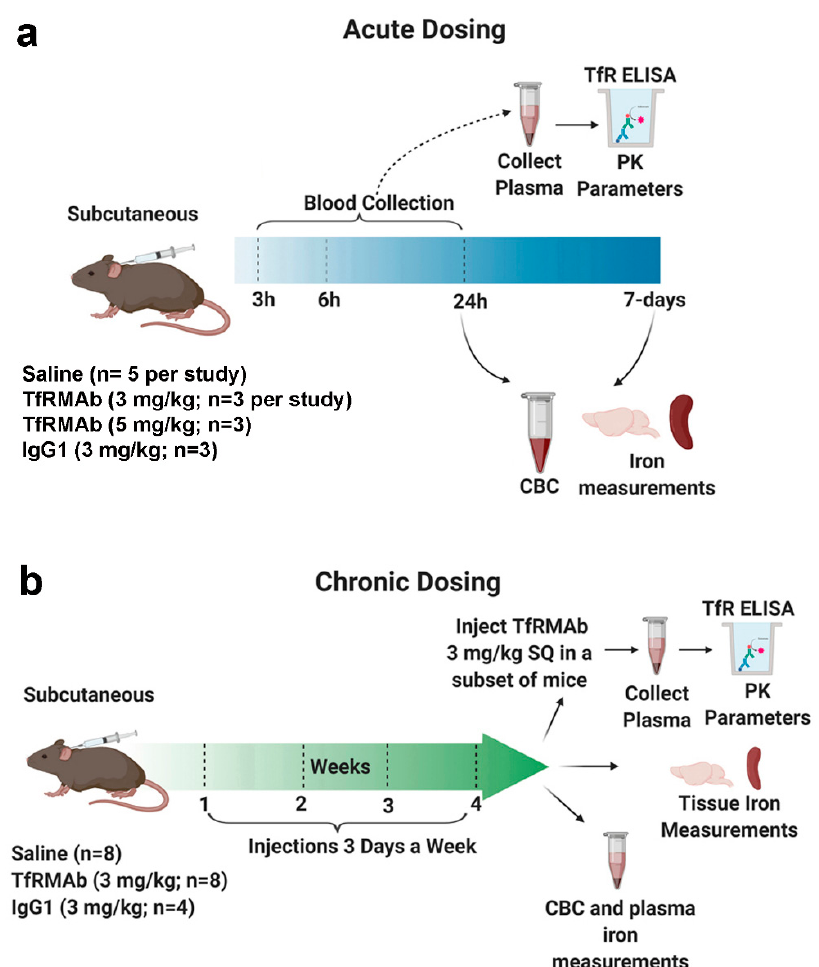
Figure 1. Schematic diagram summarizing the experimental study design for acute ( a ) and chronic ( b ) dosing. For acute dosing study, 22 mice were randomly assigned to receive 3 mg / kg ( n = 3) or 5 mg / kg ( n = 3) SQ dose of TfRMAb, 3 mg / kg SQ IgG1 control ( n = 3), or saline ( n = 5). Plasma was collected at 3-, 6-, and 24-h after injection to determine TfRMAb plasma concentrations in mice dosed with the 3 and 5 mg / kg TfRMAb. Terminal whole blood was collected for a complete blood count (CBC), and brains and spleens were excised. No CBC was performed on the 5 mg / kg dose. For the seven-day study, mice were treated with a single 3 mg / kg SQ TfRMAb dose ( n = 3) or saline ( n = 5) and observed for seven days after which whole blood was collected for a CBC, and brains were excised ( a ). For chronic dosing study, twenty mice were randomly assigned to receive saline ( n = 8), 3 mg / kg TfRMAb ( n = 8) or 3 mg / kg IgG1 ( n = 4) SQ three days a week for four weeks. Blood was collected